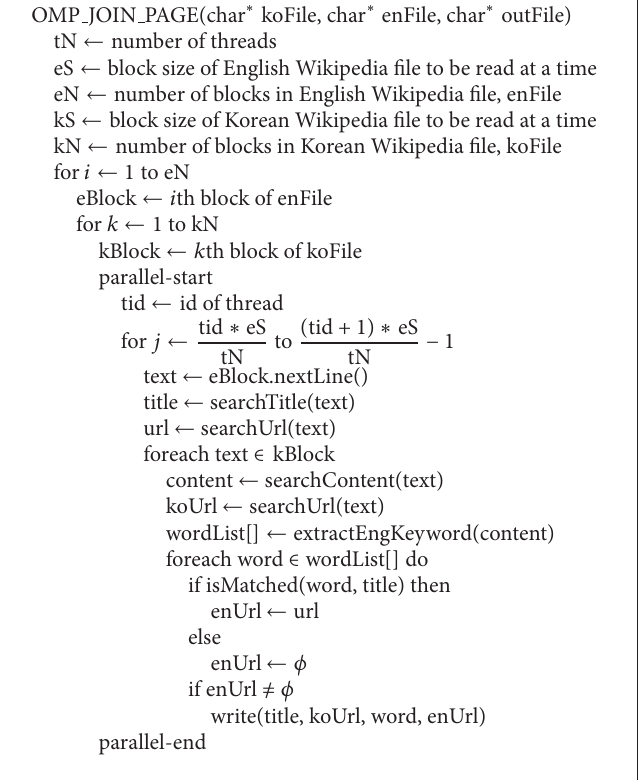
Algorithm 5: OpenMP pseudocode for the join problem.